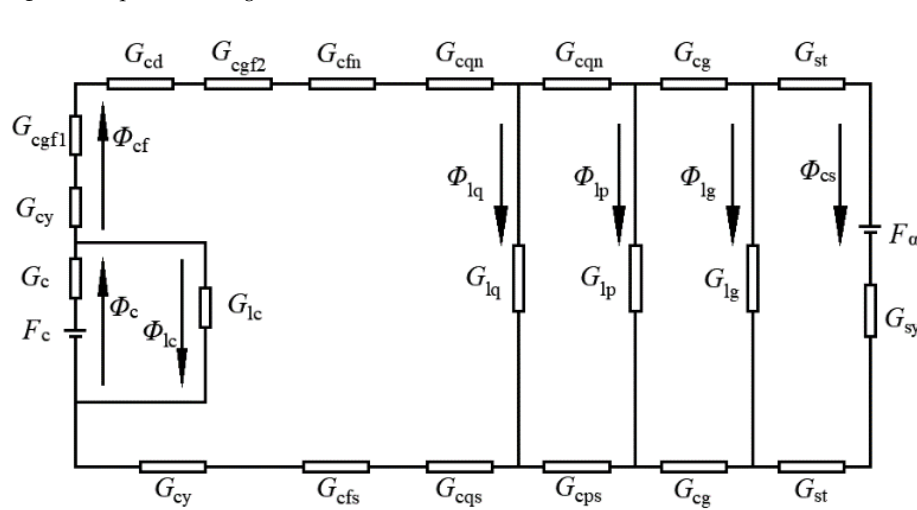
Figure 3. Equivalent magnetic network diagram.